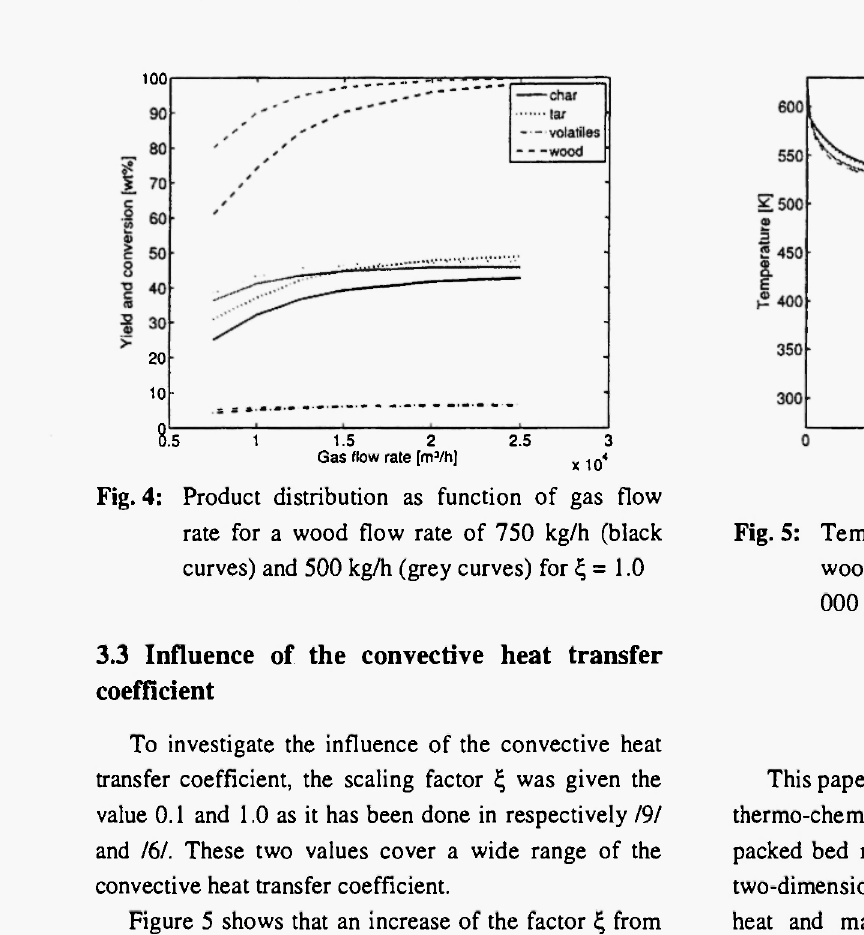
Fig. 5: Temperature of the solid phase for different wood flow rates and ξ at a gas flow rate of 10 000 m